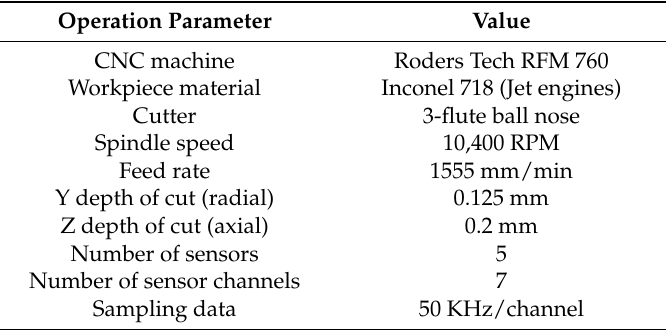
Table 1. Operation parameters in the